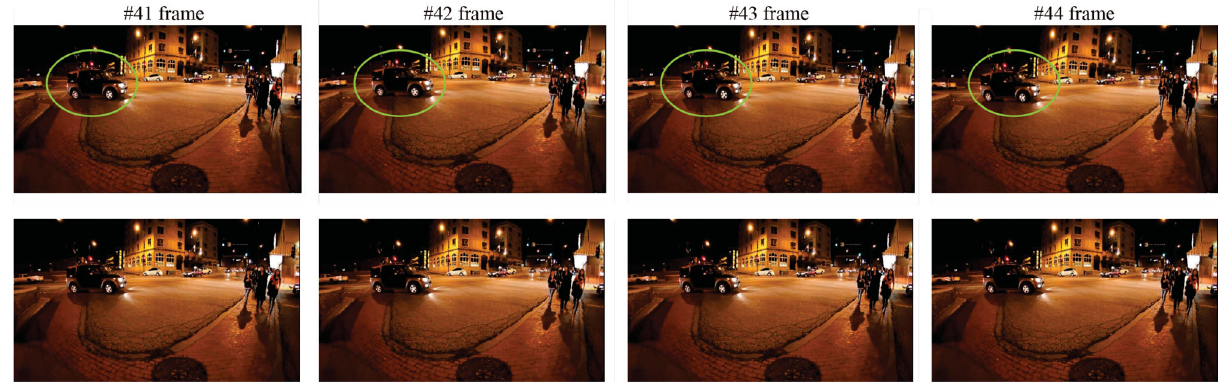
Fig. 5 Rectangling results using frame-by-frame rectangling (above) and our algorithm (below). Flickering occurs in the frame-by-frame rectangling results, especially for the car (green